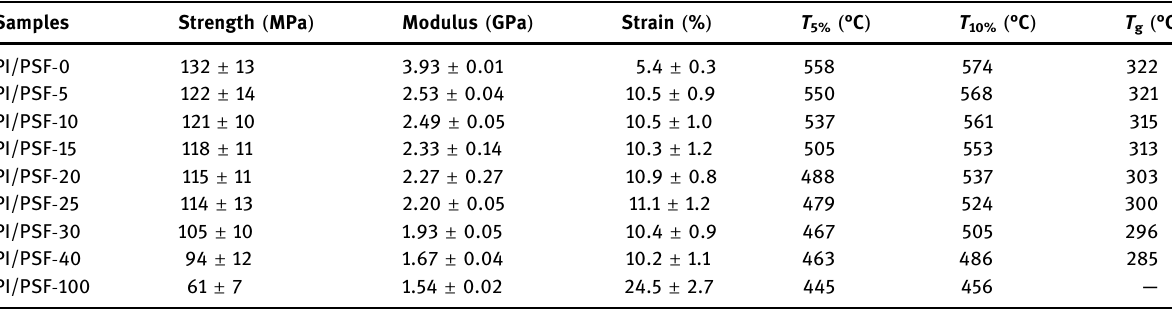
Table 2: Summary of mechanical and thermal properties of PI/PSF - X composite fi lms